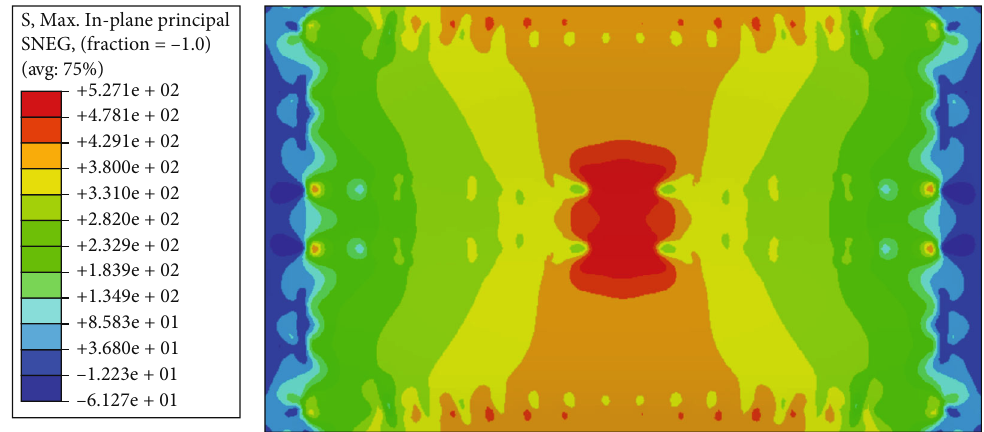
Figure 22: UMAT analysis maximum in-plain principal stress in the lower repair panel (MPa).